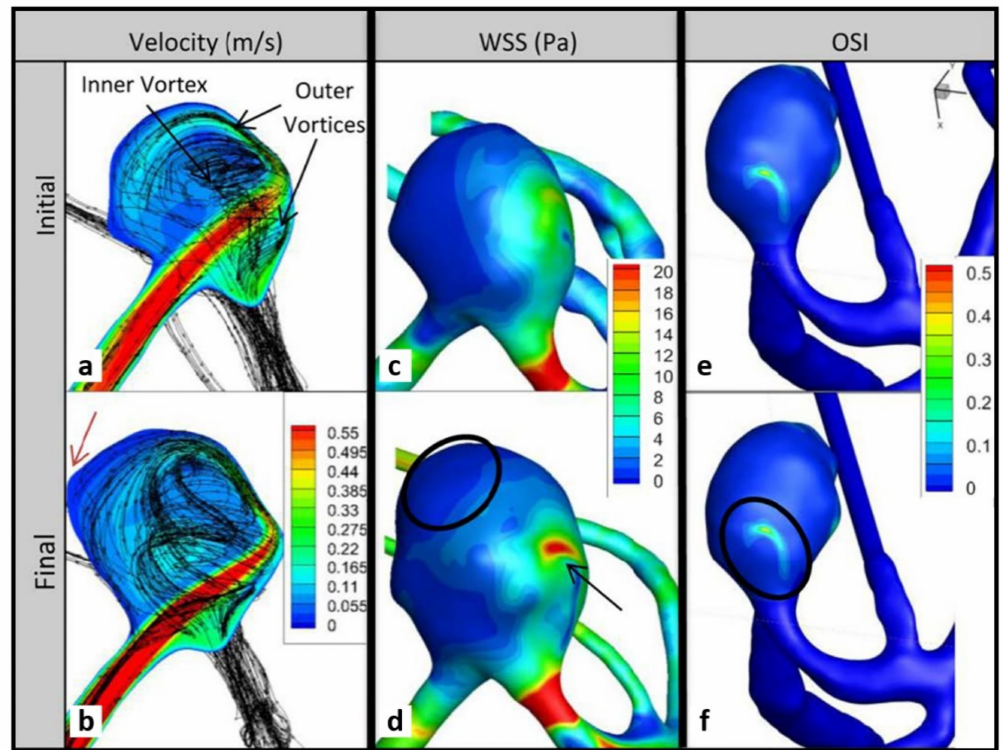
Figure 7. Impingement data planes and wall contours for P3. Velocity column shows changes in velocity between ( a ) initial and ( b ) follow-up; red arrow shows region of low velocity near higher velocity where growth occurred. WSS: changes in WSS between initial ( c ) and follow-up ( d ); black arrow shows change in WSS near the impingement region and circle shows region of significant growth. OSI: changes in OSI between initial ( e ) and follow-up ( f